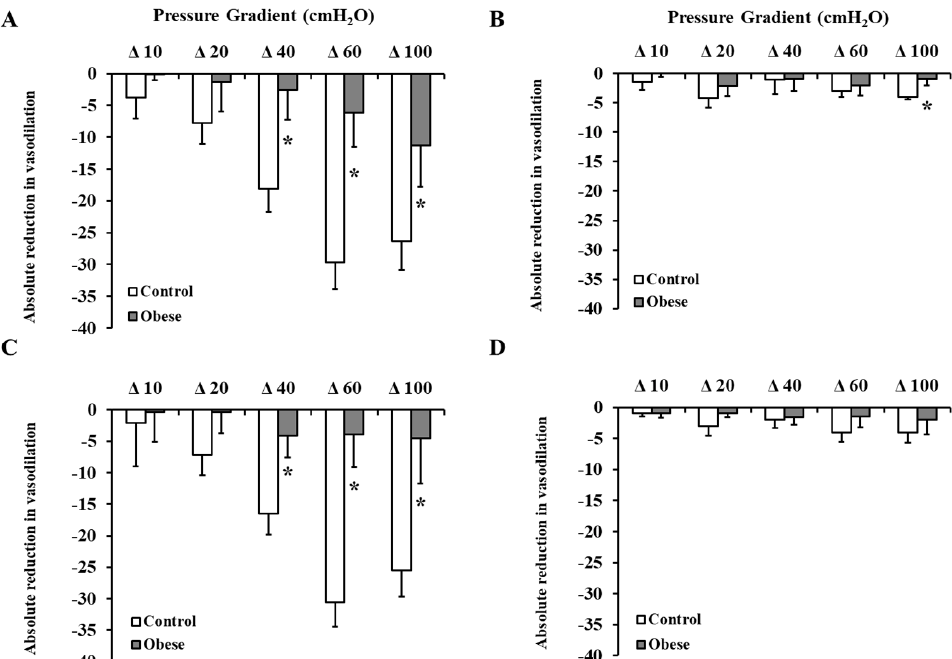
Figure 5. Effect of Hcy incubation on baseline FID and L-NAME-mediated reduction in FID. SAT ( A , B ) and VAT ( C , D ) isolated arterioles from obese subjects ( n = 10) and non-obese controls ( n = 10) were incubated in100 µM of Hcy for 180 min followed by measuring FID with and without eNOS inhibition via L-NAME (10 − 4 M). Charts ( A,C ) present absolute reductions in FID in Hcy preconditioned arterioles compared to corresponding unconditioned arterioles. Charts ( B,D ) present absolute reduction in FID caused by L-NAME in Hcy preconditioned arterioles compared with baseline FID after Hcy incubation. All measurements are presented as means ± standard error (SE). * ( p < 0.05) for comparing obese subjects with controls.